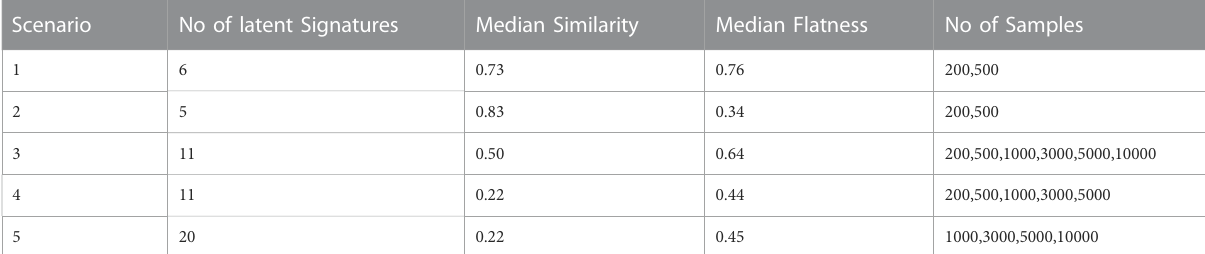
TABLE 1 Summary of the de novo extraction scenario. For each simulated scenario, the number of active signatures, the cosine similarity level. the fl atness level and the n ° of samples.